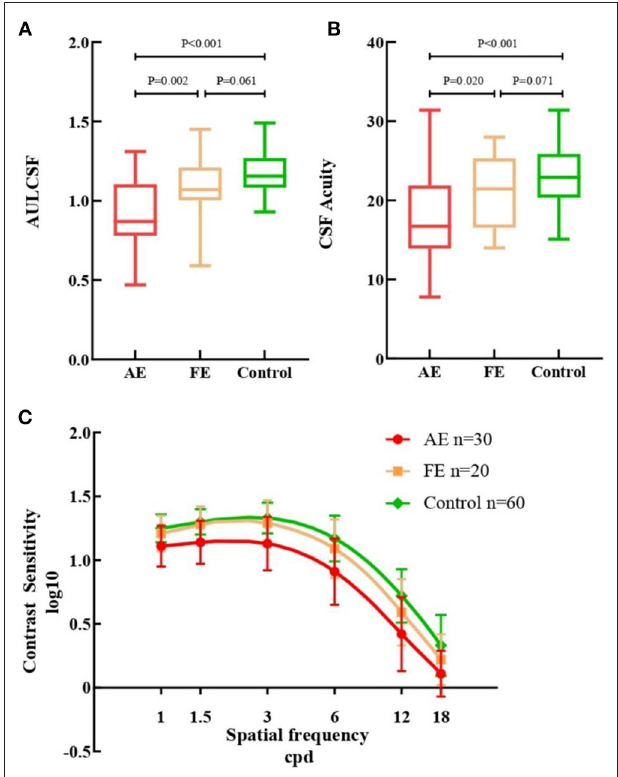
FIGURE 1 | Measurements from quick contrast sensitivity function testing. (A) Box plots of AULCSF for the three groups. (B) Box plots of CSF Acuity for the three groups. (C) Contrast sensitivity of all cpd in AE (red), FE (yellow) and controls (green). AULCSF, the area under log contrast sensitivity function; CSF acuity, the spatial frequency at which contrast sensitivity was 100%; AE, FUS-affected eyes of patients; FE, fellow eyes of patients. Error bars represent ± standard deviation (SD); cpd, cycle per